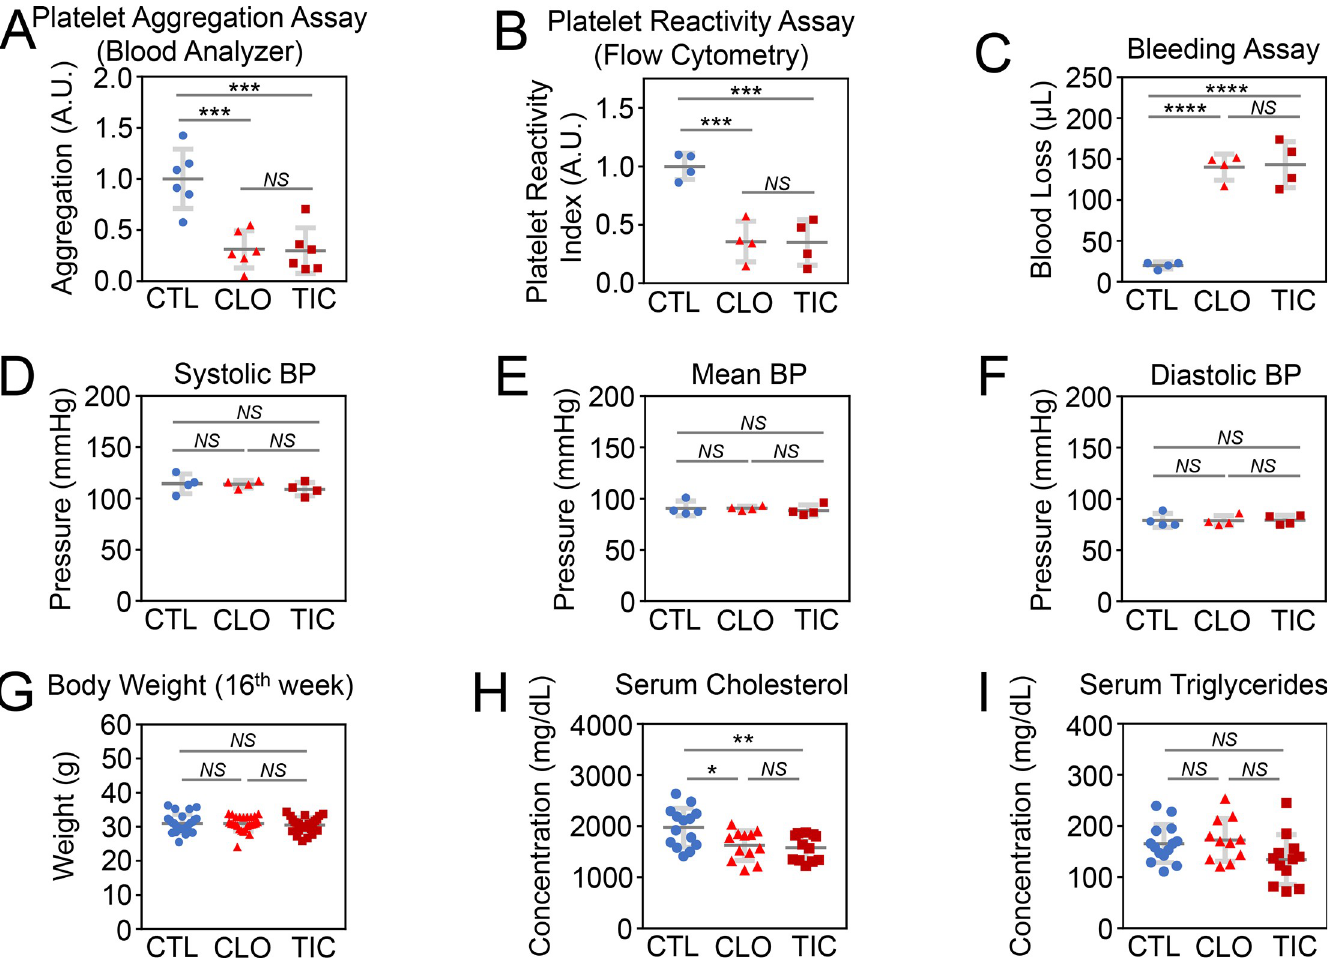
Fig 1. Clopidogrel and ticagrelor equally inhibit platelet aggregation at 25 mg/kg/day and 180 mg/kg/day, respectively. Abbreviations: CTL, control; CLO, clopidogrel; TIC, ticagrelor; A.U., arbitrary units; RPI, platelet reactivity index; BP, blood pressure; N = 4–6 per group for (A–F), 26 for (G), and 11–14 for (H–I); Error bars, means ± SD, statistical analyses performed using ANOVA with Fisher’s multiple comparison; NS, not statistically significant; � , P < 0.05; �� , P < 0.01; ��� , P < 0.005; ���� , P < 0.001 (See also S1 Fig) . (A) Platelet aggregation assay using a hematology blood analyzer. (B) Platelet reactivity index (RPI) using flow cytometry. (C) Bleeding assay using tail blood loss measurement. (D) Systolic blood pressure measured. (E) Mean blood pressure calculated. (F) Diastolic blood pressure measured. (G) Body weights at 16 th week of treatment with a high-fat diet (HFD). (H) Serum cholesterol measured at 16 th week of treatment with a HFD. (I) Serum triglyceride measured at the 16 th week of treatment with a